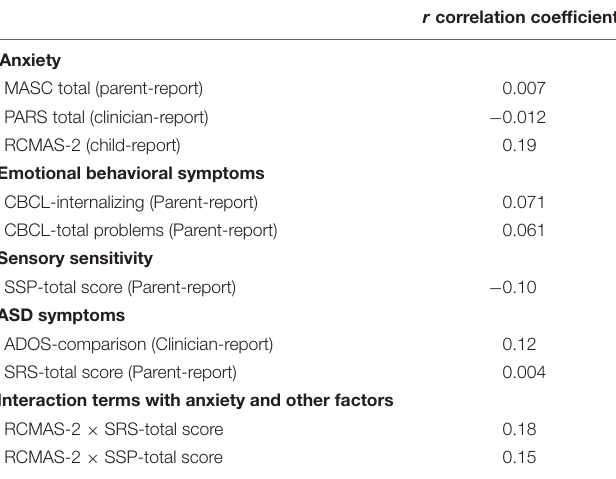
TABLE 3 | Correlations between clinical variables and ACDAS.